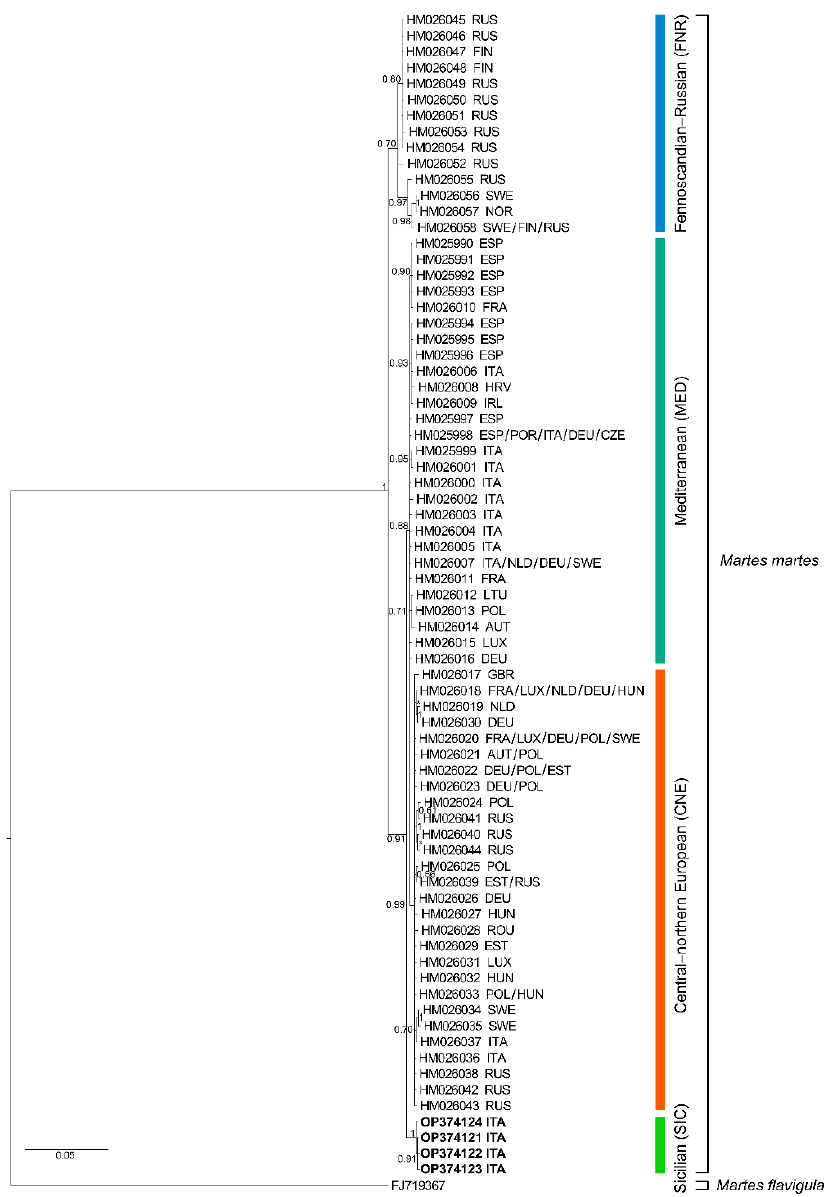
Figure 1. Bayesian phylogram (50% majority rule consensus tree) for Martes spp. based on the 1563-bp long “mtDNA I” fragment. A sample of Martes flavigula was used as outgroup. Node statistical support is reported as nodal posterior probabilities. Asterisks indicate posterior probability values lower than 50. Rectangles refer to the major phylogroups identified by Ruiz-Gonzáles et al. [15] [i.e., Mediterranean (MED), Central–Northern European (CNE), Fennoscandian–Russian (FNR) phylogroups], plus the novel Sicilian phylogroup (SIC). Square brackets group the samples according to the current taxonomy of the genus. Our novel sequences are reported in bold. The three-letter country codes shown in the figure are reported according to the “ISO 3166-1 alpha-3 standard.